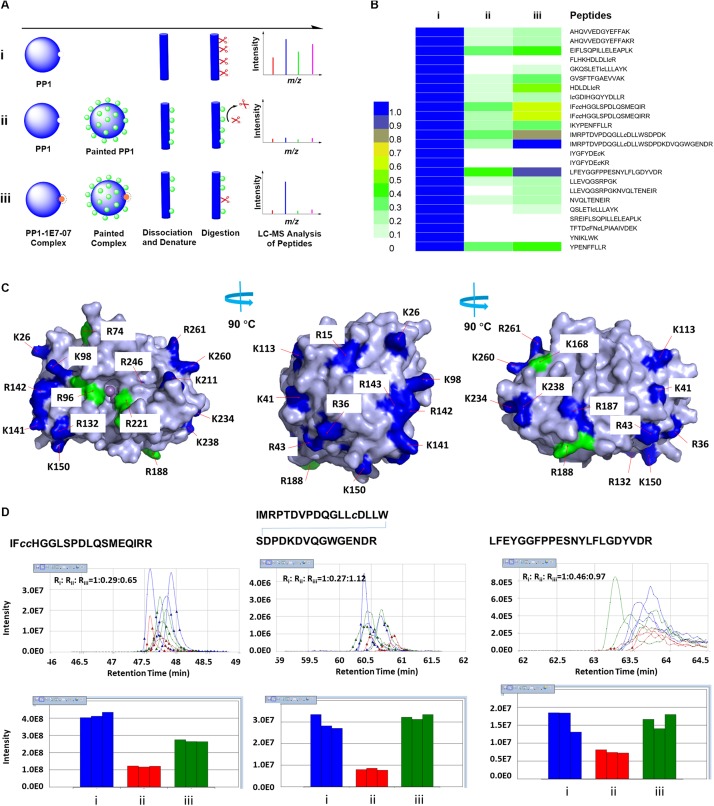
Identification of PP1 binding sites for 1E7-07 by protein painting. (A) Schematic of the protein painting workflow showing (i) unpainted PP1; (ii) PP1 painted by molecule ELNLLB; and (iii) protection of PP1 from ELNLLB painting by 1E7-07. (B) Heat map of peptides derived from PP1 quantified among groups (i), (ii), and (iii). Label-free quantification using SIEVE 2.1 software with identified PP1 peptides as framing seeds. The scale from 0-1 represents the ratio of group (ii) or (iii) vs. group (i). (C) 1E7-07 binding protected PP1 from ELNLLB painting. All cleavage sites except K111 and R122 were mapped on the surface of PP1 and colored blue or green, among which the major protection sites of 1E7-07 from ELNLLB painting were colored green. The models were generated with PyMOL 1.5. (D) SIEVE quantitative data of major protection peptides. Ion elution profiles (top) and integrated intensities (bottom) are shown in blue for (i), in red for (ii), and in green for (iii). The data was shown in triplicate and the ratios among different groups were also labeled.